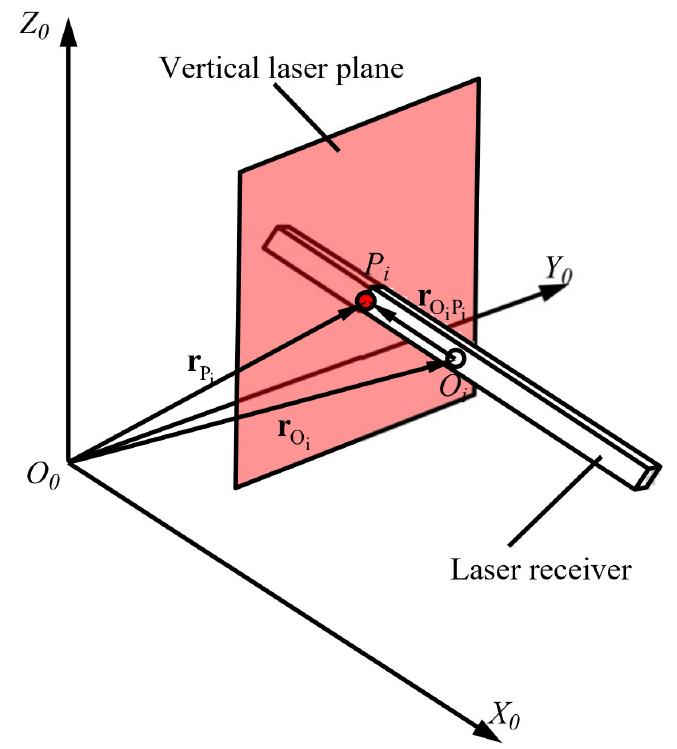
Figure 2. Principle of pose parameter space